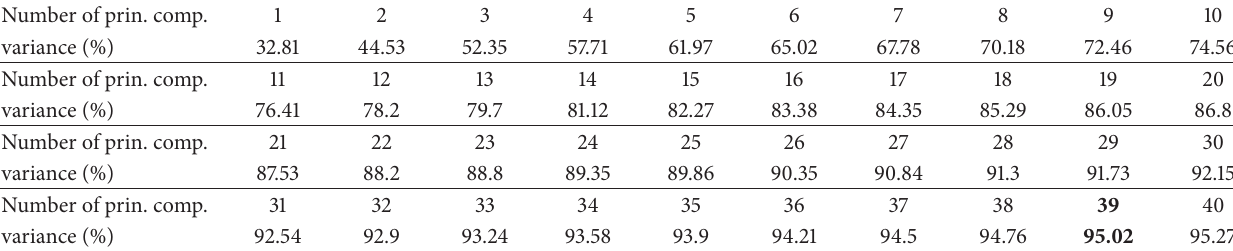
Table 1: Detailed data of PCA.